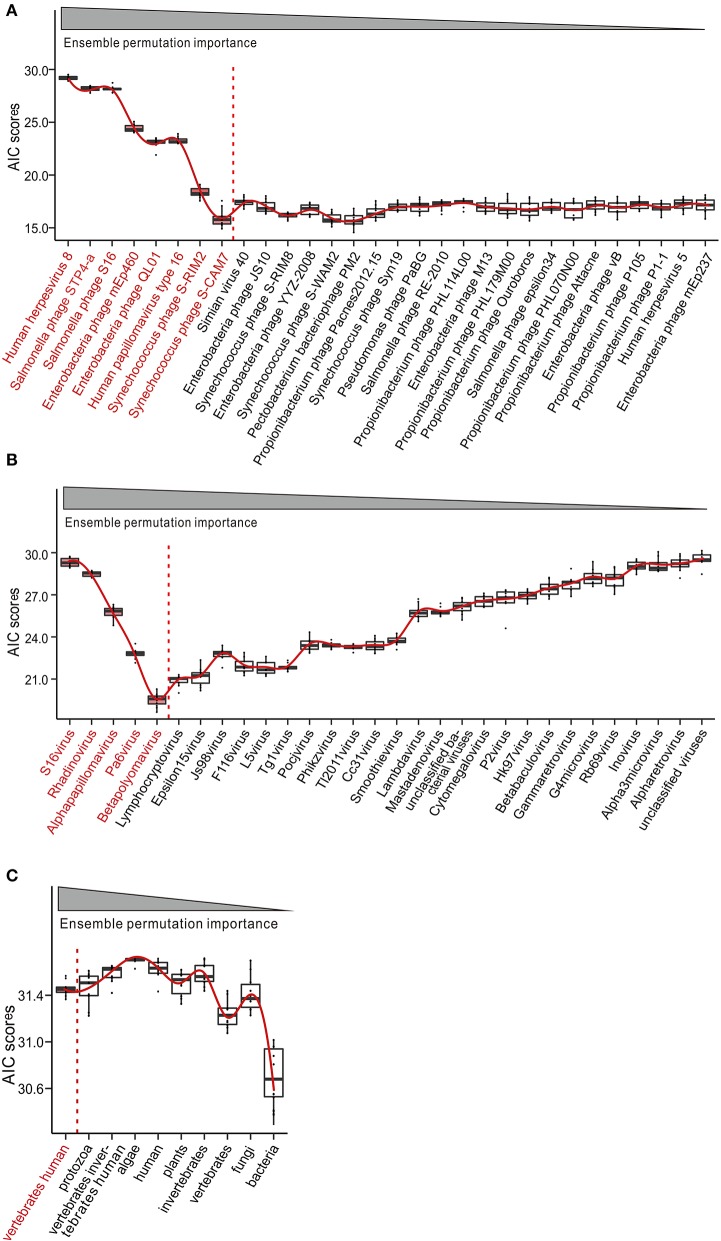
Potential of peripheral blood mononuclear cell (PBMC) virome taxa for the diagnosis of systemic lupus erythematosus (SLE). Construction and evaluation of logistic regression (LR) classifiers with ensemble permutation importance measure-guided forward selections of diagnosis predictors at species (A), genus (B), and host (C) levels. Akaike Information Criterions (AIC) were computed using out-of-bag (OOB) predicted morbidity scores from 1,000 iterations of LR modeling. Red line indicates the curve fitting. Color-coded taxa (black) represent the optimal diagnostic predictors.